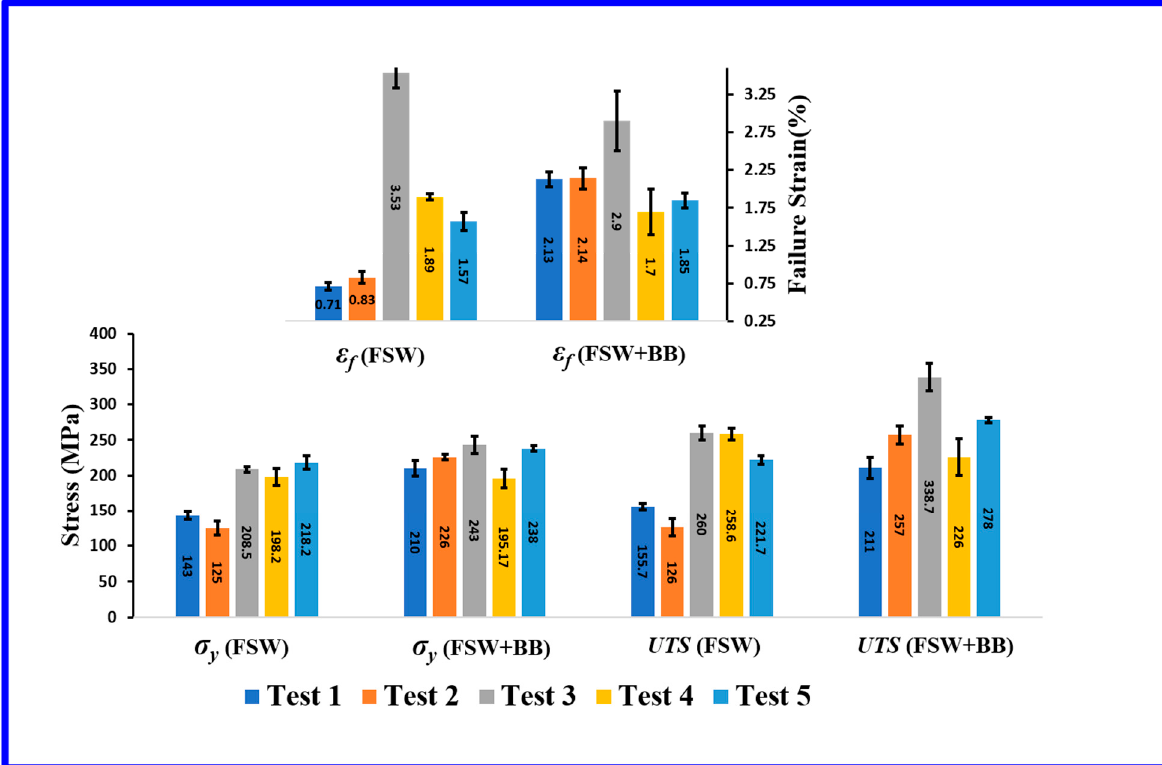
Figure 12. Comparison of mechanical characteristics ( σ y , UTS , ε f ) for FSW and FSW + BB speci-